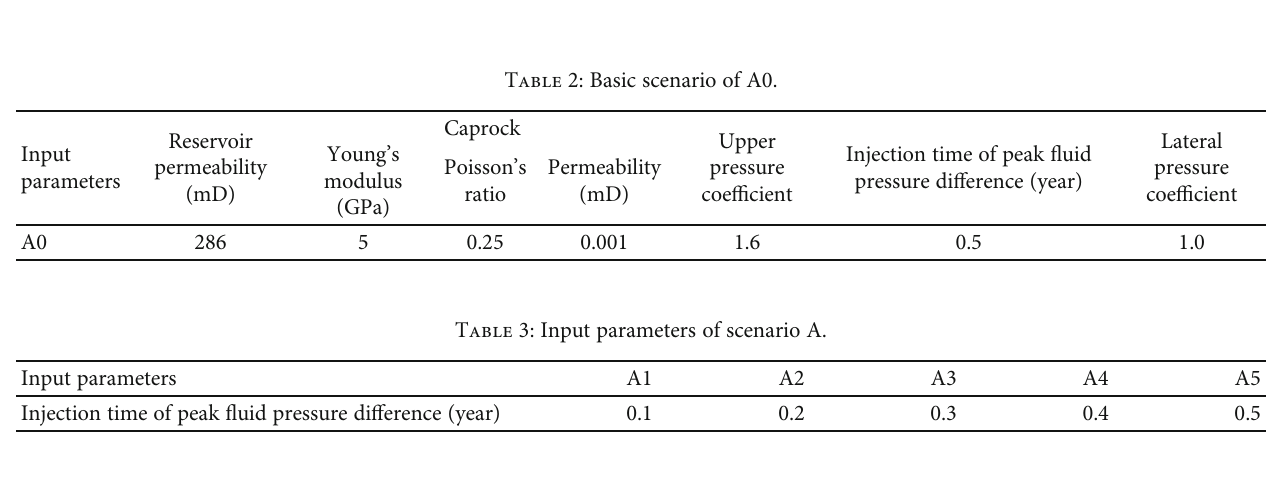
Table 4: Input parameters of scenario B.